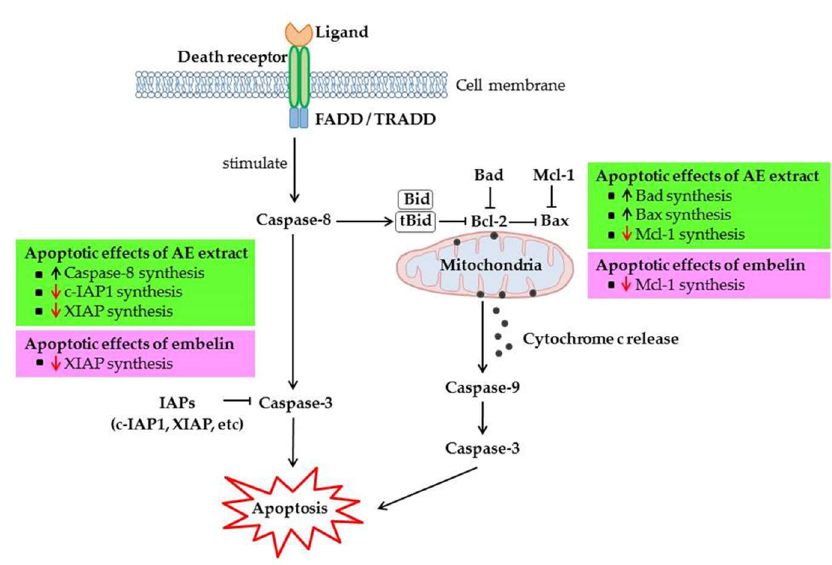
Figure 5. Schematic diagram illustrating the mechanisms of A. elliptica fruit extract (AE extract) and embelin on apoptotic pathway in HCT-116 cells.